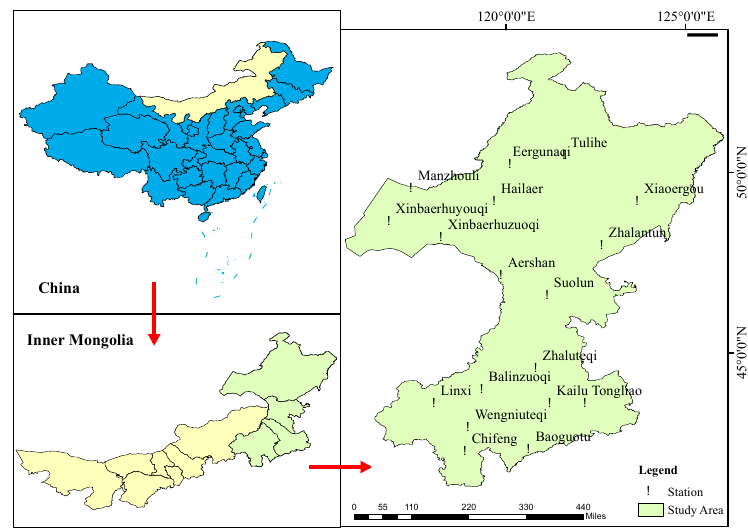
Figure 1. Spatial distribution of the weather stations. Table 1. Geographic and meteorological information of the 18 weather stations and the cluster num- ber of weather stations during the period 1960–2019.